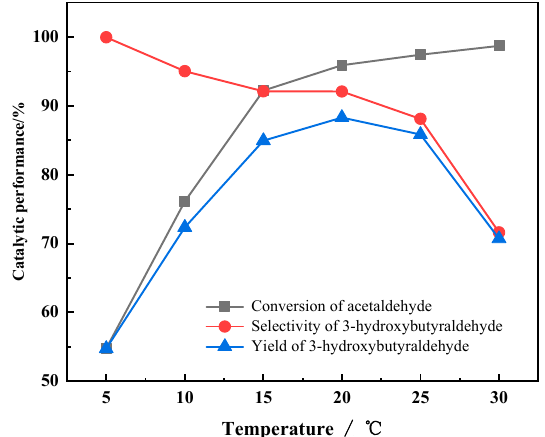
Figure 7. Effect of reaction temperature on AcH condensation.